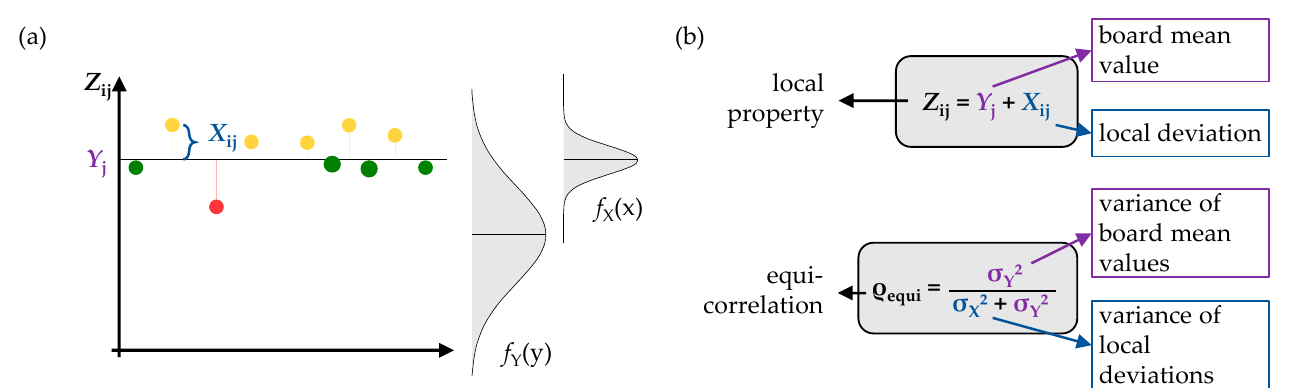
Figure 5. Two-level probabilistic hierarchical model ( a ) as well as the formal definitions of its main components ( b ).